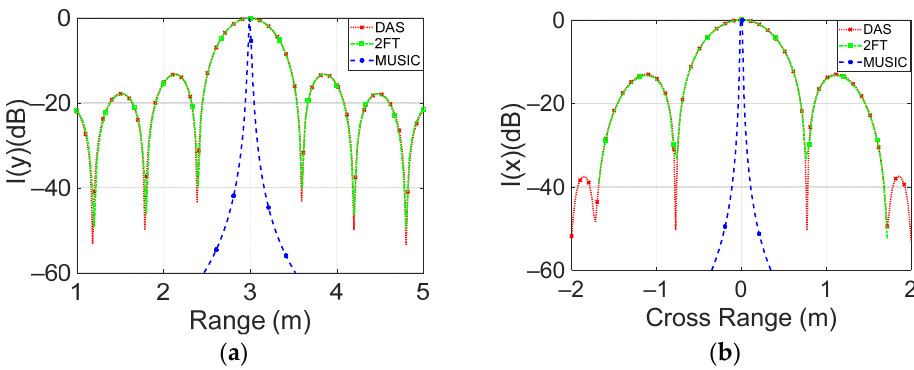
Figure 14. Comparison between the three considered techniques in the presence of a single target. The normalized intensity function versus ( a ) range and ( b ) cross-range distance is reported.